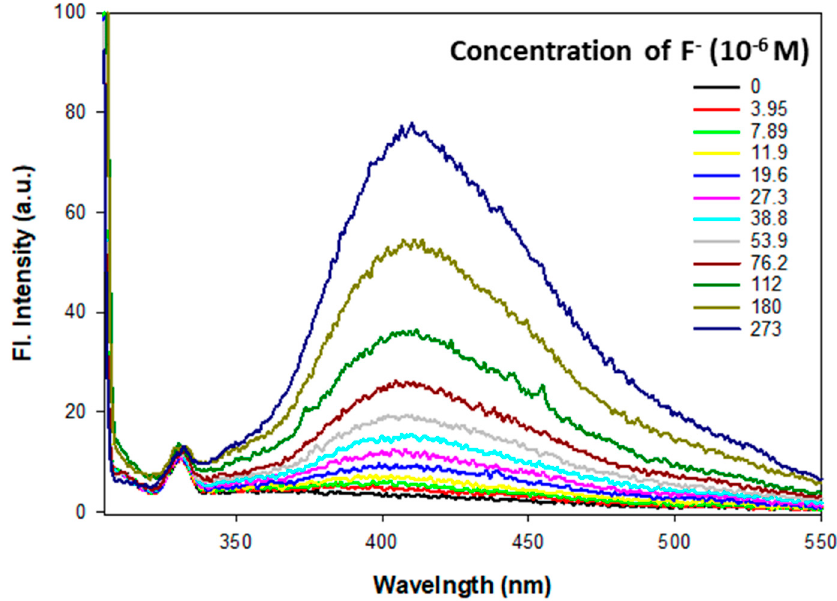
Figure 6. Fluorescence spectra of P07 (0.1 mol% P03 , solvent: toluene) treated with TBAF (stock